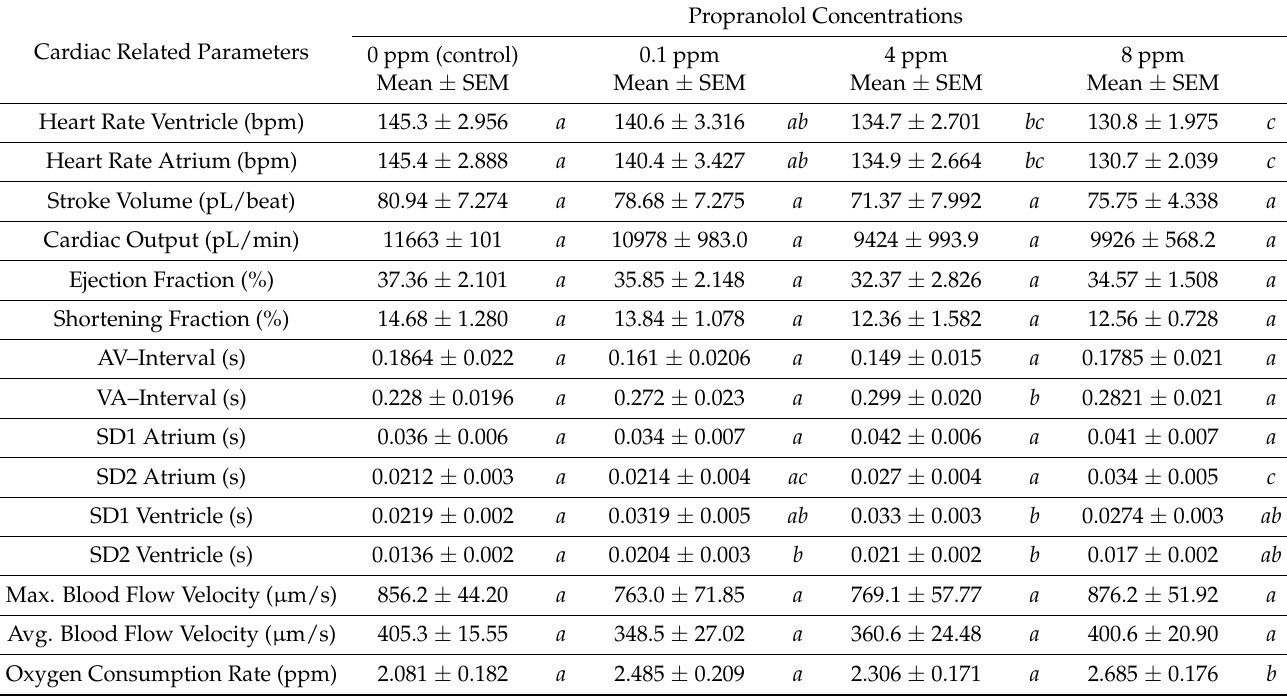
Table A2. Comparison of cardiac performance, blood flow velocity, and oxygen consumption in larval zebrafish after treated with 5 different doses of